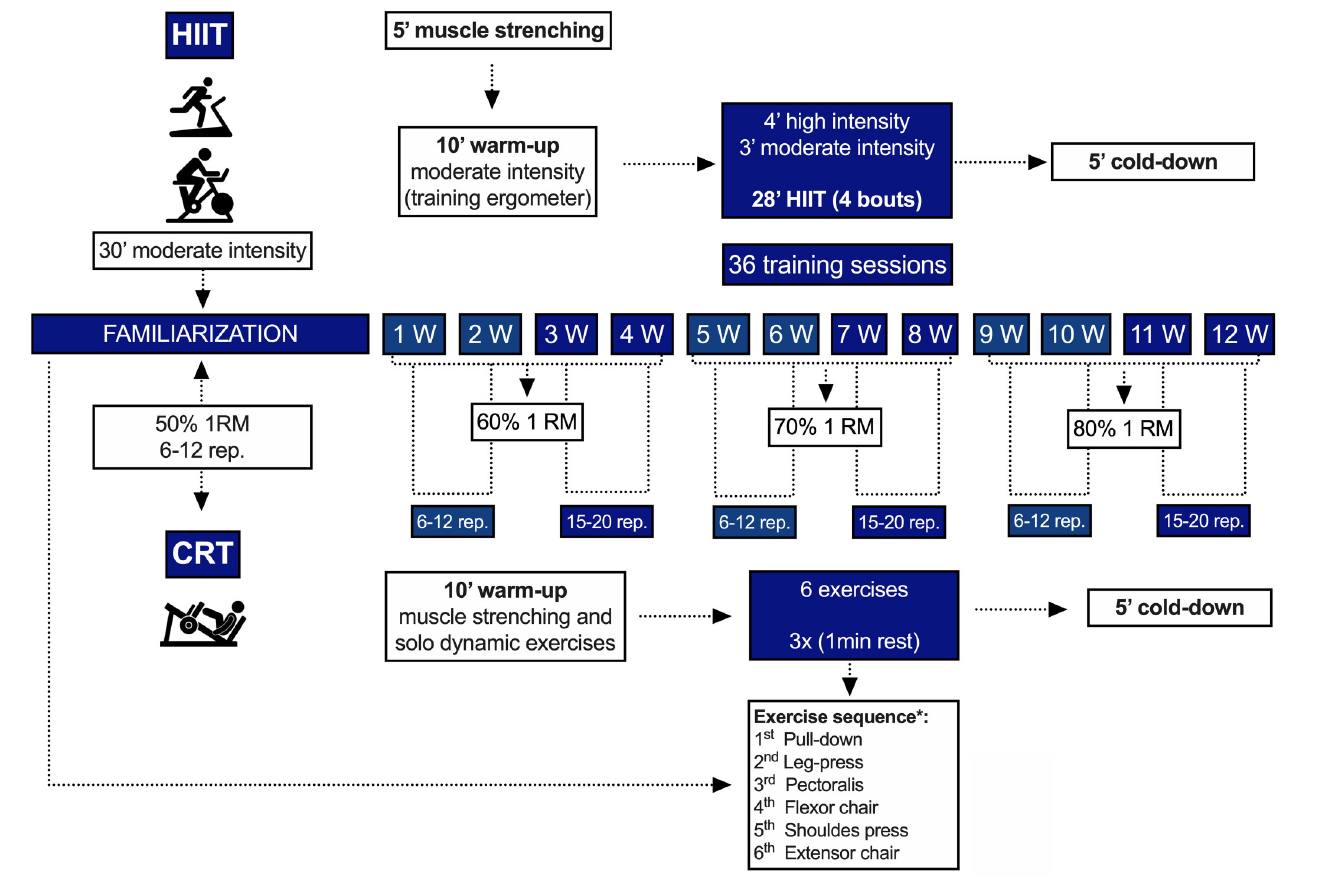
Fig 3. Training protocol. Design of the training protocol. HIIT, high-intensity interval training; CRT, circuit-resistance training; 1RM, one-repetition maximum; W, weeks; rep, repetitions; min, minute.